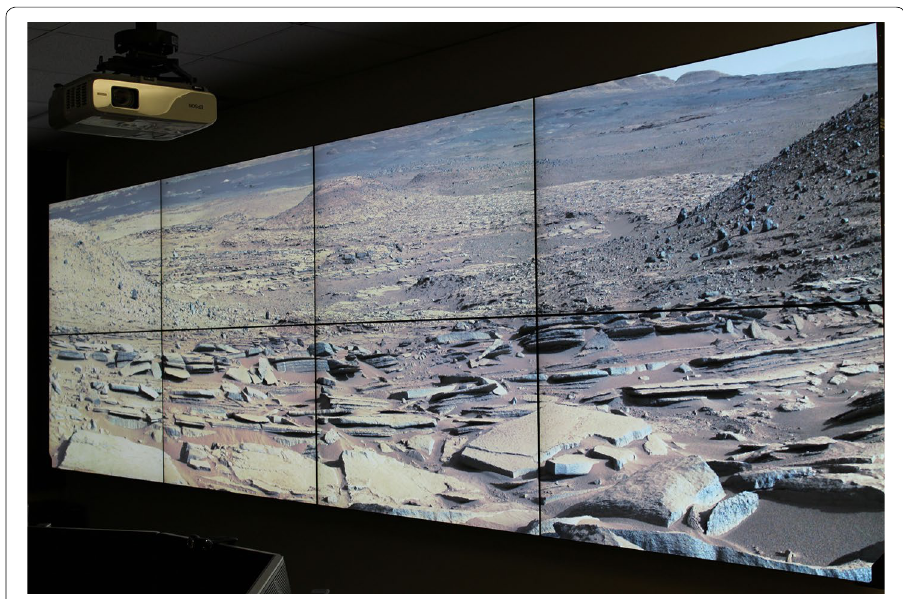
Fig. 5 A high resolution picture of the surface of Mars taken by NASA’s Curiosity rover displayed on the Hiperwall Display Wall